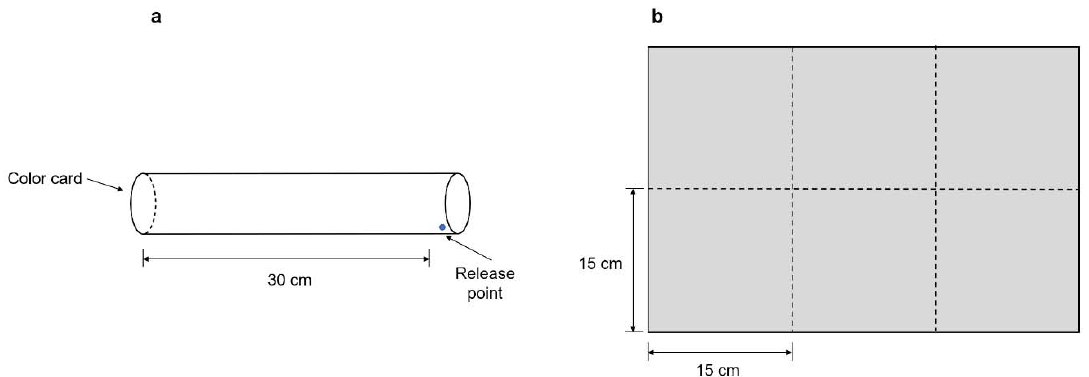
Figure 1. Design of the cylinder (no ‐ choice, a ) and black cardboard (free ‐ choice, b ) used for evaluation of visual cues in orientation behaviors. A cylinder of 30 cm is shown, and other experimental cylinders only differed in length. Cardboard used for testing color preferences in free ‐ choice, and all of the sticky cards were cut into squares (15 cm × 15 cm), and were randomly pasted on the black cardboard.